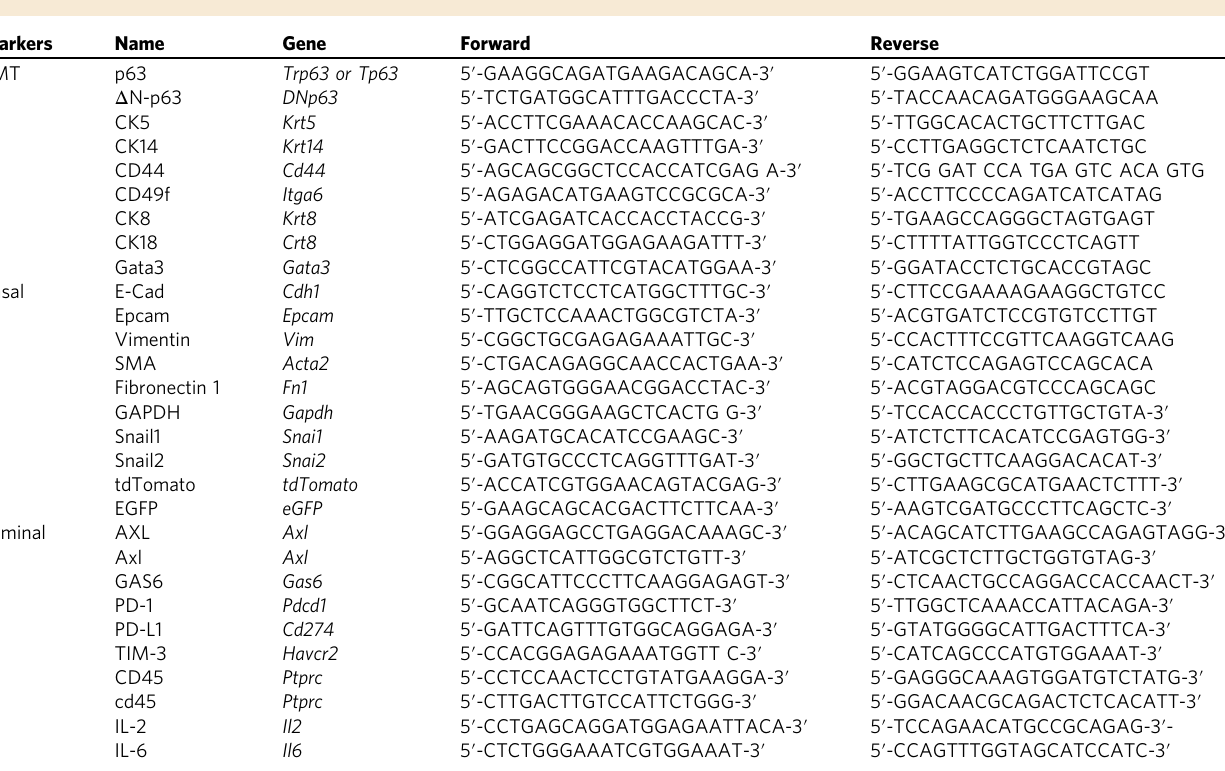
Table 2 Primer sequences for q-PCR